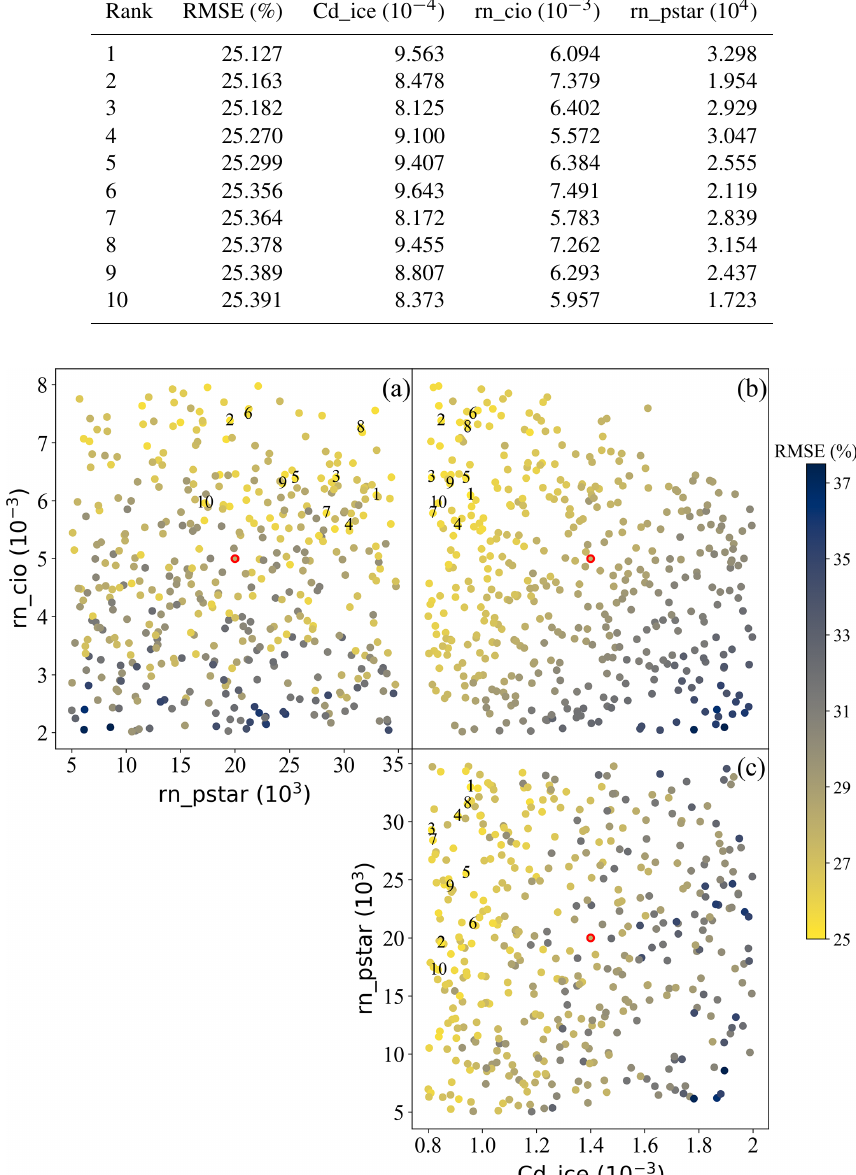
Table 3. The 10 best-performing experiments in terms of mean RMSE SICB (i.e. RMSE between simulated and observed SIC budget) and the values of the three key parameters they used. Note that these values highly correspond to the DRAKKAR Forcing Set version 5.2 (Dussin et al., 2016) atmospheric forcing used in this study.